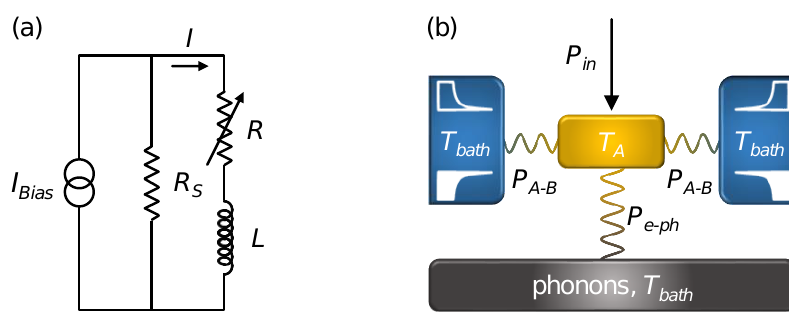
Figure 6. General thermal and electrical model of the nano-transition edge sensor (TES) and Josephson escape sensor (JES). ( a ) Schematic representation of a typical biasing circuit for the nano-TES and JES. The parallel connection of the sensor (of variable resistance R ) and the shunt resistor ( R S ) is biased by the current I Bias . The role of R S is to limit the Joule overheating of A when transitioning to the normal-state. The variations of the current ( I ) flowing through the sensing element are measured by means of the inductance L . For instance, an inductively-coupled SQUID amplifier could serve as read-out element. ( b ) Thermal model of the nano-sensors, where the main thermal exchange channels are shown. P in is the power coming from the incoming radiation, and P e − ph is the heat exchanged between electrons in the active region (yellow) at T A and lattice phonons (grey) at T bath , while P A − B is the heat current flowing towards the superconducting electrodes (blue) residing at T bath